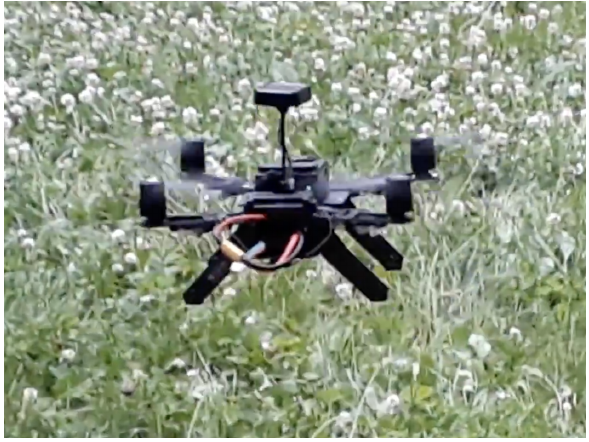
Figure 7. Our aerial vehicle: